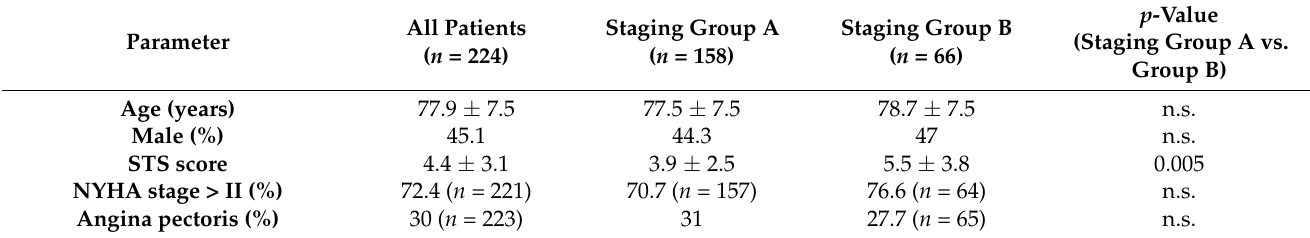
Table 1. Baseline characteristics of the patients included in the study: entire collective and predefined staging groups A and B. Parameter